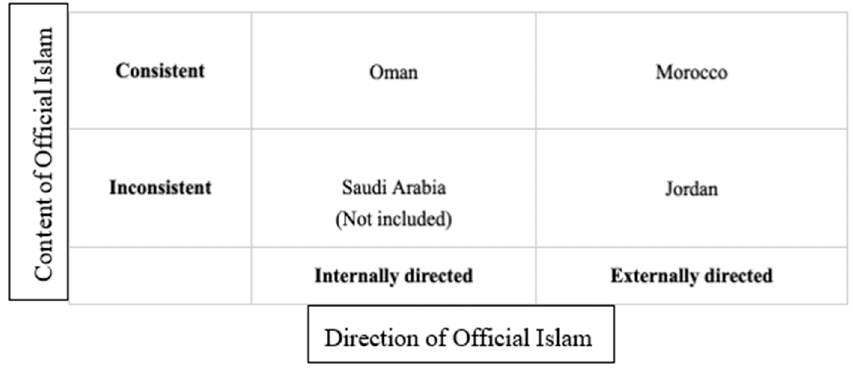
Figure 2. Evaluating Resonance in Three Case Studies & a Shadow Case.